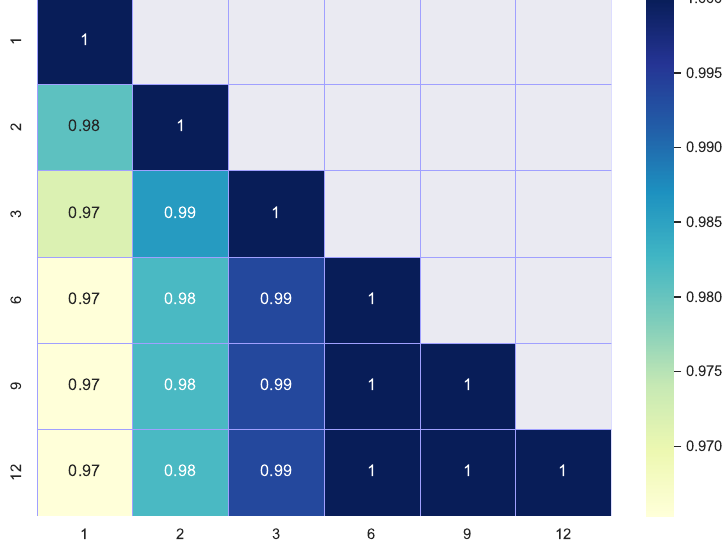
Figure 14. Heatmap of classification coincidences for